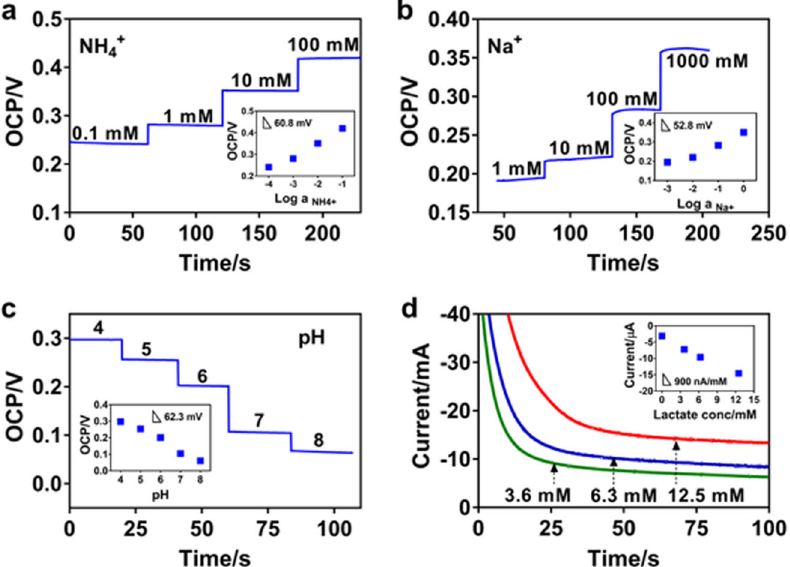
Fig. 4 Performance of thread-based sweat sensors. Potentiometric response of a ammonium, b sodium, c pH and chronoamperometric response of d lactate using fi lter paper soaked in different concentration of respective analyte solution. Inset a – d shows the calibration plot of the respective thread sensors. Fig. 5. Characterization of sensitivity reproducibility for pH and sodium sensors can be seen in Supplementary Fig. 6.